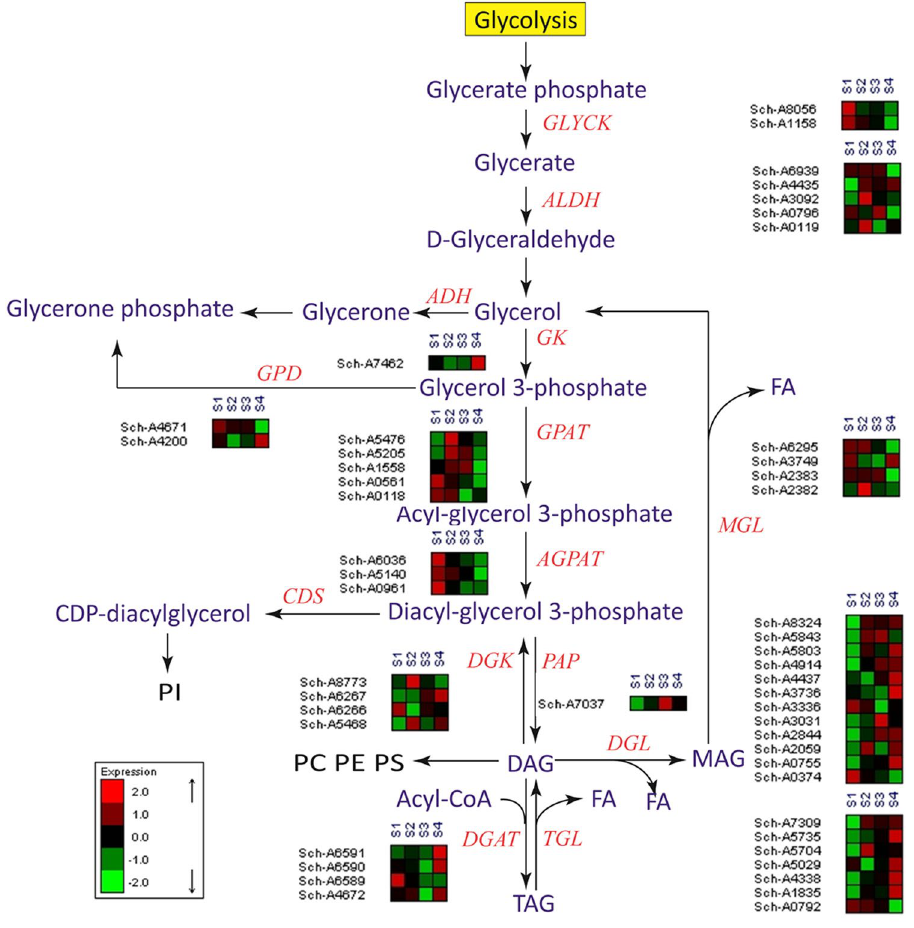
Figure 3. Regulation of key enzymes related to glycerolipid metabolism and glycerophospholipid metabolism in Schizochytrium sp. HX-308. GLYCK: Glycerate kinase; ALDH: Aldehyde dehydrogenase; GK: Glycerate kinase; GPAT: Glycerol-3-phosphate-O-acyltransferase; AGPAT: 1-acyl-sn-glycerol-3-phosphate acyltransferase; PAP: Phosphatidate phosphatase; DGAT: Diacylglycerol acyltransferase; DGK: Diacylglycerol kinase; TGL: Triacylglycerol lipase; DGL: Diacylglycerol lipase; MGL: Acylglycerol lipase; GPD: Glyceraldehyde 3-phosphate